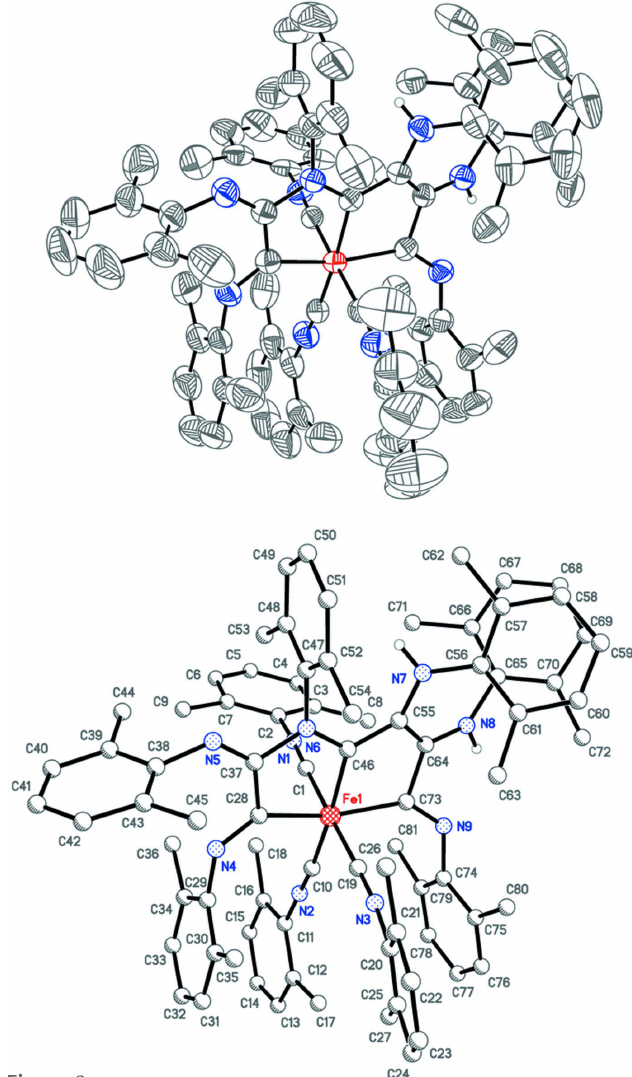
Figure 2 Plots of 2 with C—H hydrogen atoms and solvent molecules omitted and with only the major components of disorder shown. Top: anisotropic displacement ellipsoid plot drawn at the 50% probability level. Bottom: ball-and-stick plot in the same orientation featuring the numbering